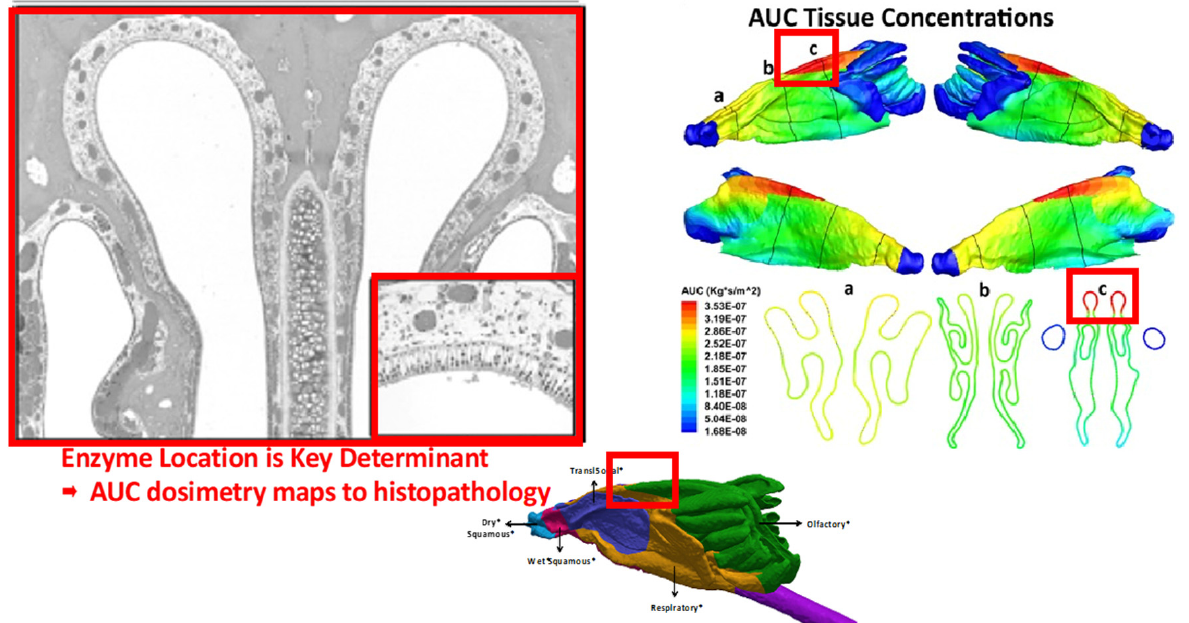
Figure 4. Histopathology section through anterior dorsal olfactory epithelium of the rat nasal airway corresponding to locations of maximum epithelial tissue concentrations of acetaldehyde (AUC) following 6 h/d, 5 d/wk inhalation exposures (from [64,69]; part of NAM-03 presentation, Supplemental File).